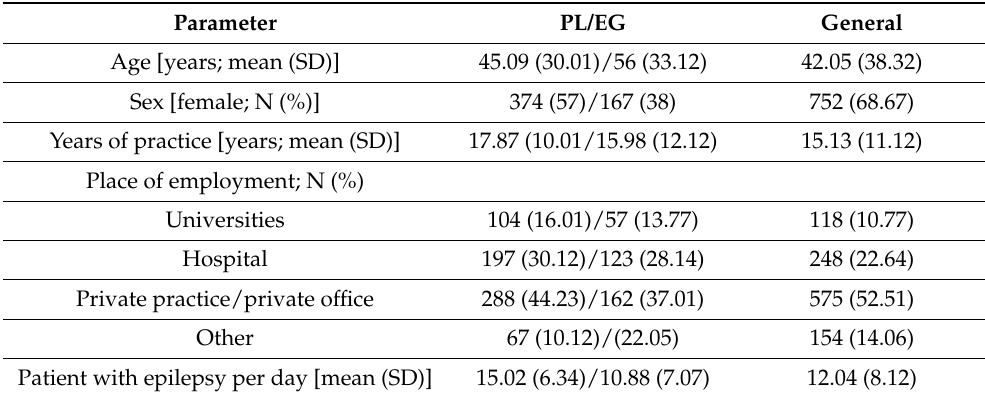
Table 1. Demographic characteristics of neurologists ( n =